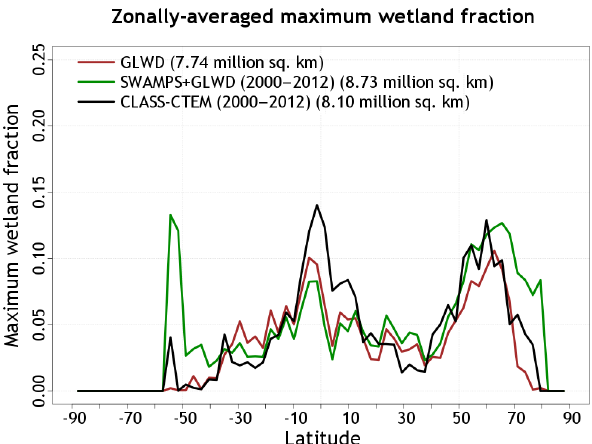
Figure 6. Comparison of simulated zonally averaged maximum wetland fraction over land with observation-based estimates based on the Global Lakes and Wetland (GLWD; Lehner and Döll, 2004) and a new product that is formed by merging remote sensing based observations of daily surface inundation from the Surface Water Mi- crowave Product Series (SWAMPS; Schroeder et al., 2015) with the static inventory of wetland area from the GLWD as explained in Poulter et al.